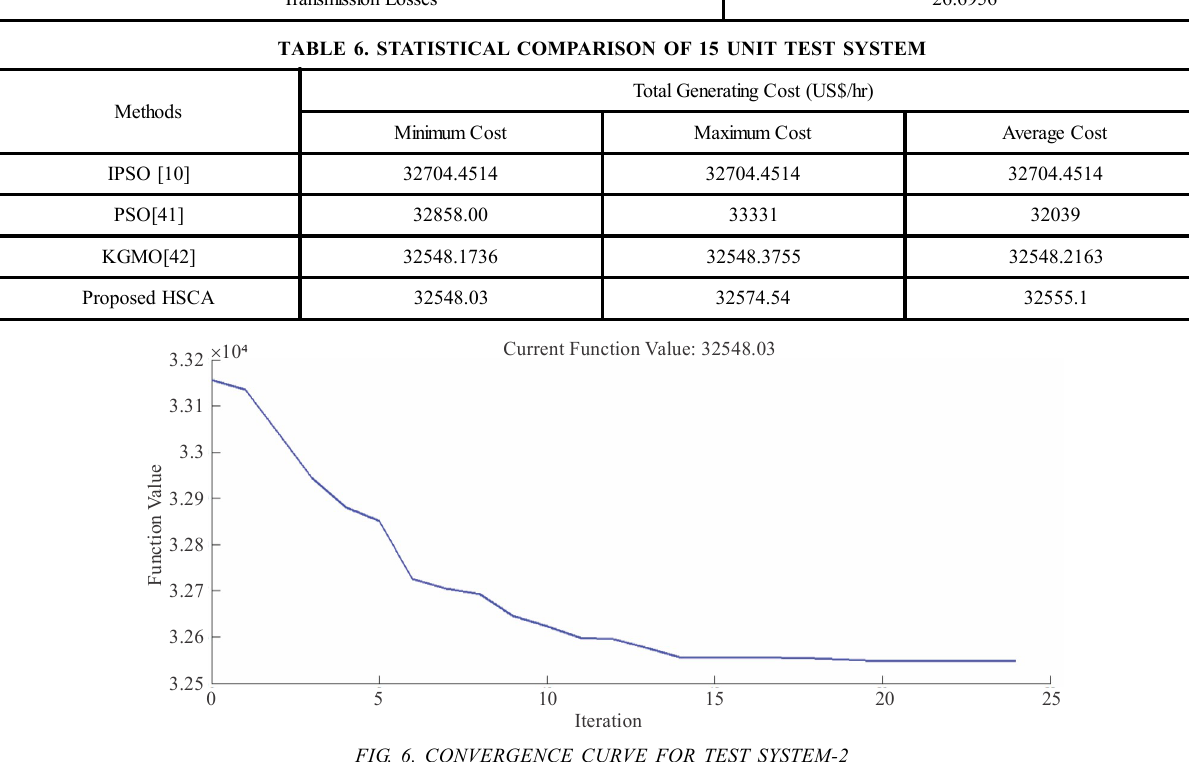
TABLE 6. STATISTICAL COMPARISON OF 15 UNIT TEST SYSTEM